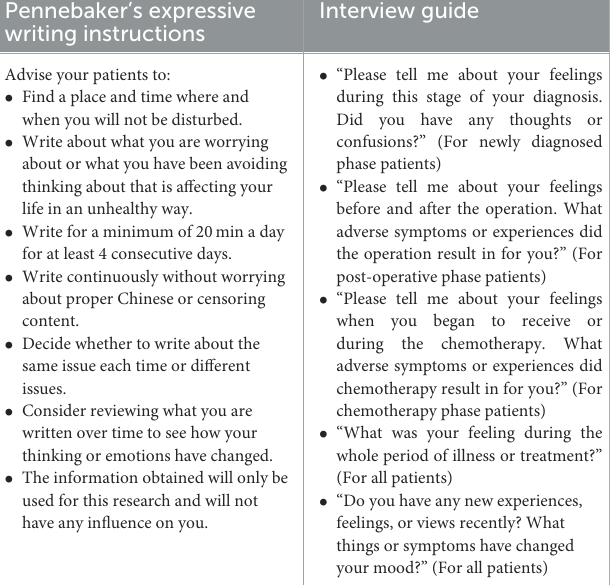
TABLE 2 The demographic characteristics of participants in expressive writing and interviews.